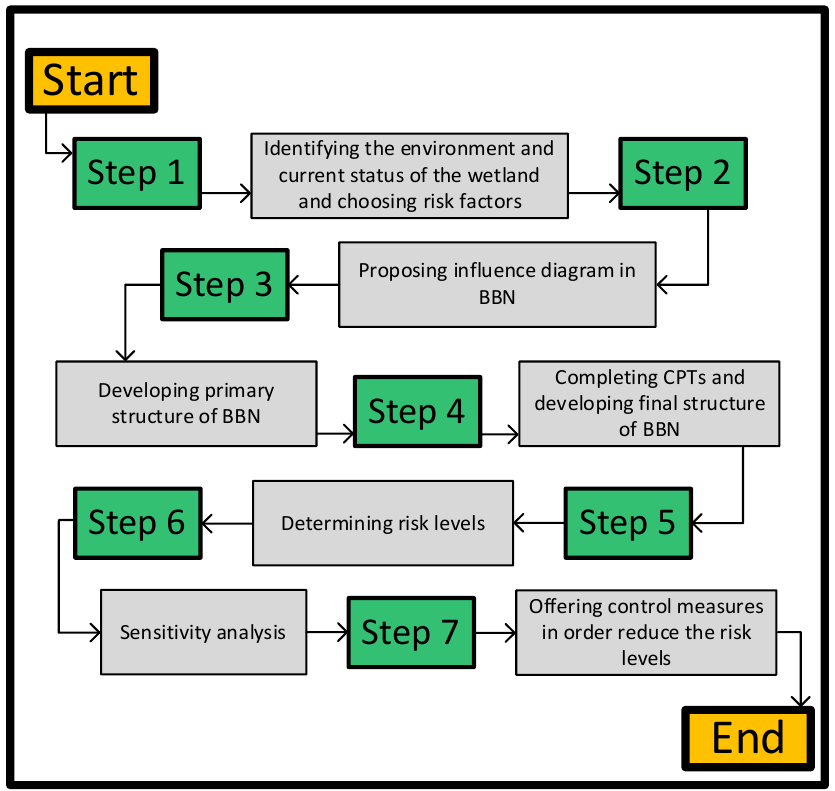
Figure 2. A methodological framework adopted for determining the risk levels of wetland ecosystems.